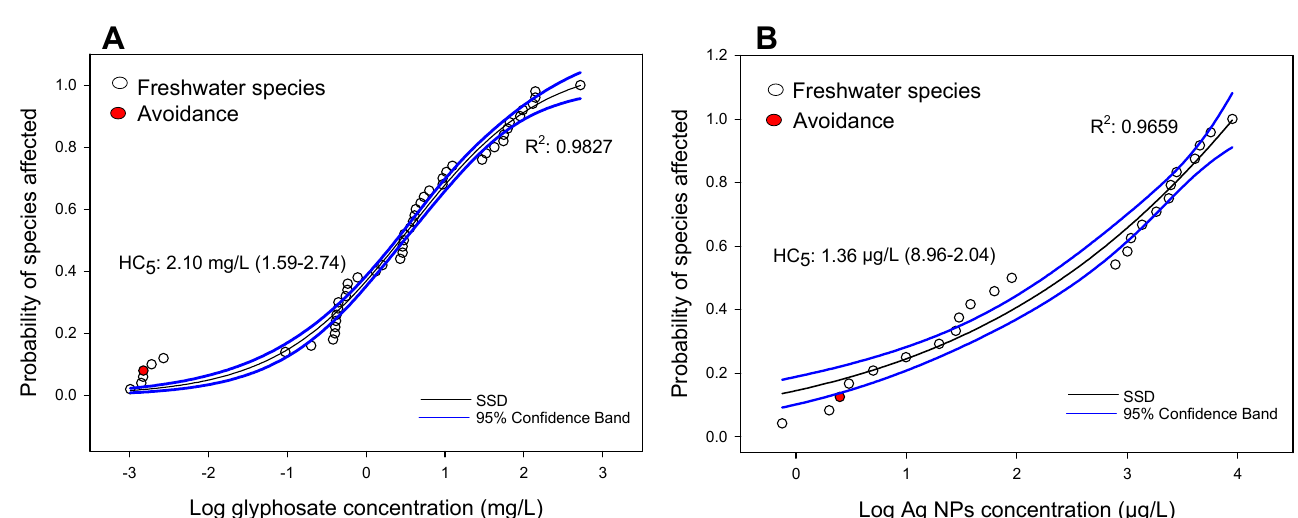
Figure 5. Species sensitive distribution (SSD), and 95% confidence intervals, expressed as the probability of the species being affected according to the log of the glyphosate ( A ) and Ag-NPs ( B ) concentrations, considering the freshwater species. The spatial avoidance response is represented by red circles. Values of hazard concentrations for 5% of the species (HC 5 ) and the confidence intervals are also shown for each group of data.